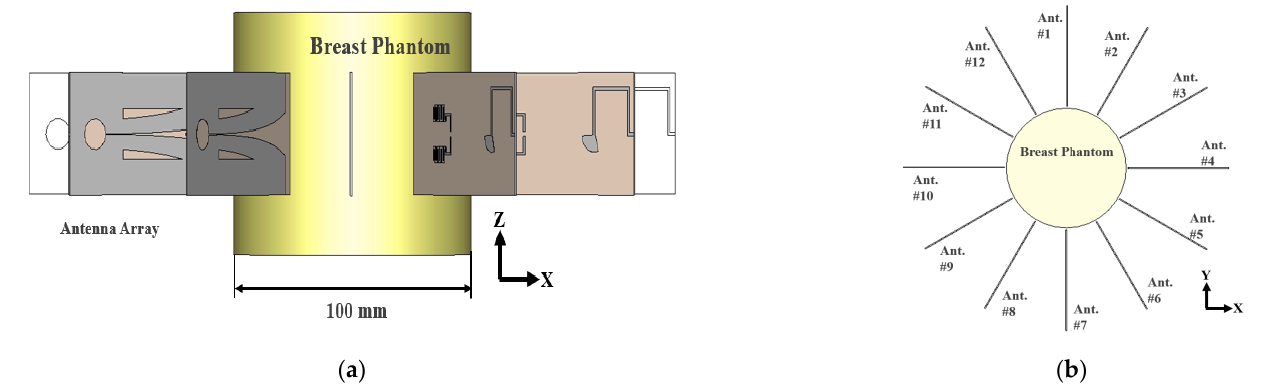
Figure 4. The 3D model of the cylindrical TSA antenna array with vertical polarization: ( a ) xz-plane and ( b ) xy-plane.